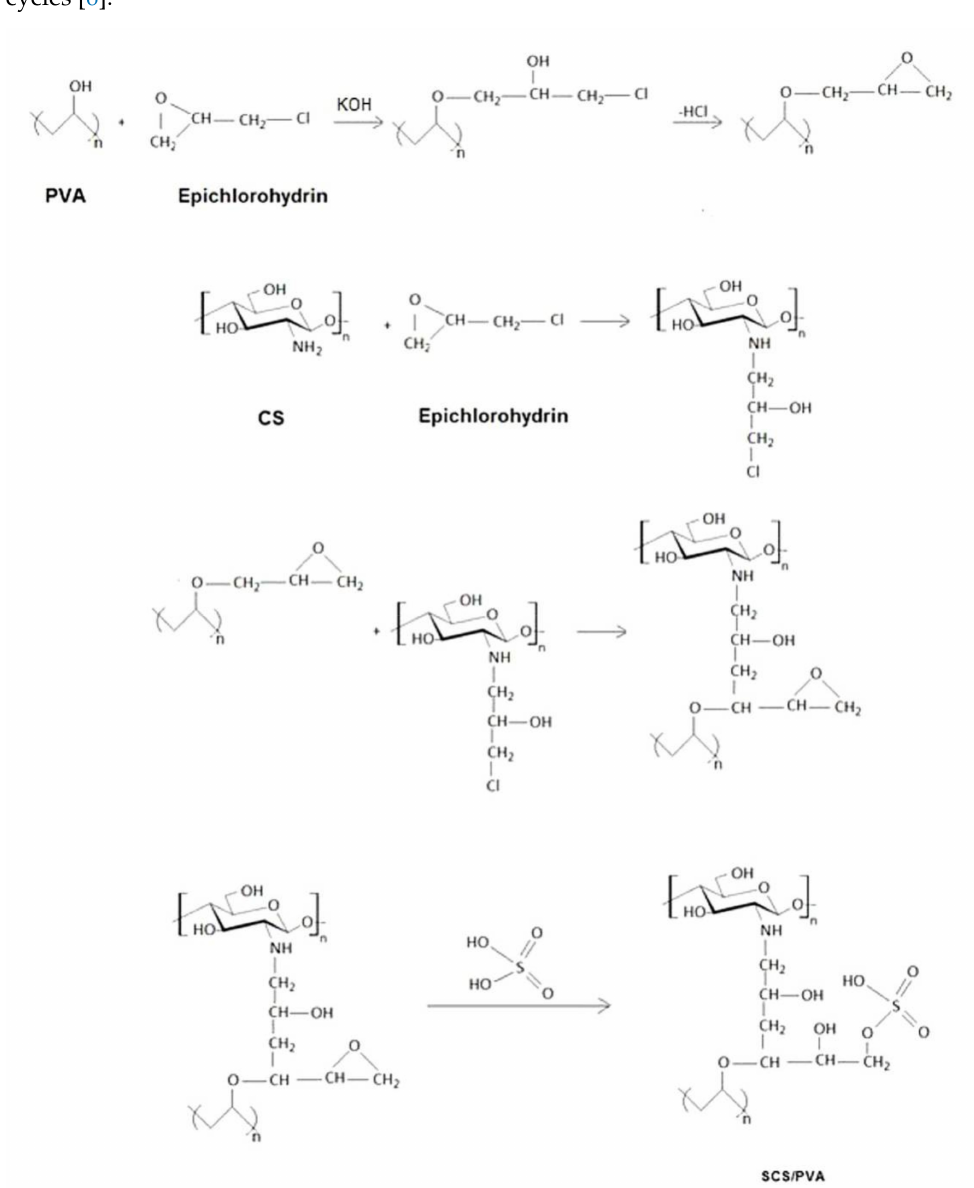
Figure 2. Synthetic route for the sulfonated chitosan/polyvinyl alcohol membrane (SCS/PVA). Reprinted from